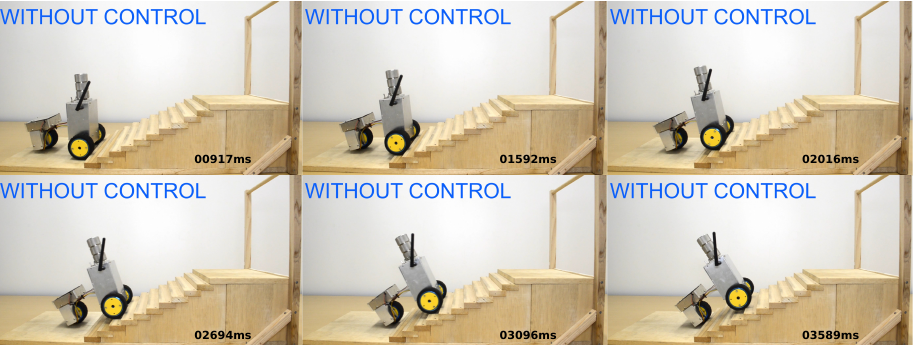
Figure 18. Prototype ascending without control (time stamps in milliseconds are roughly estimated from the videos).